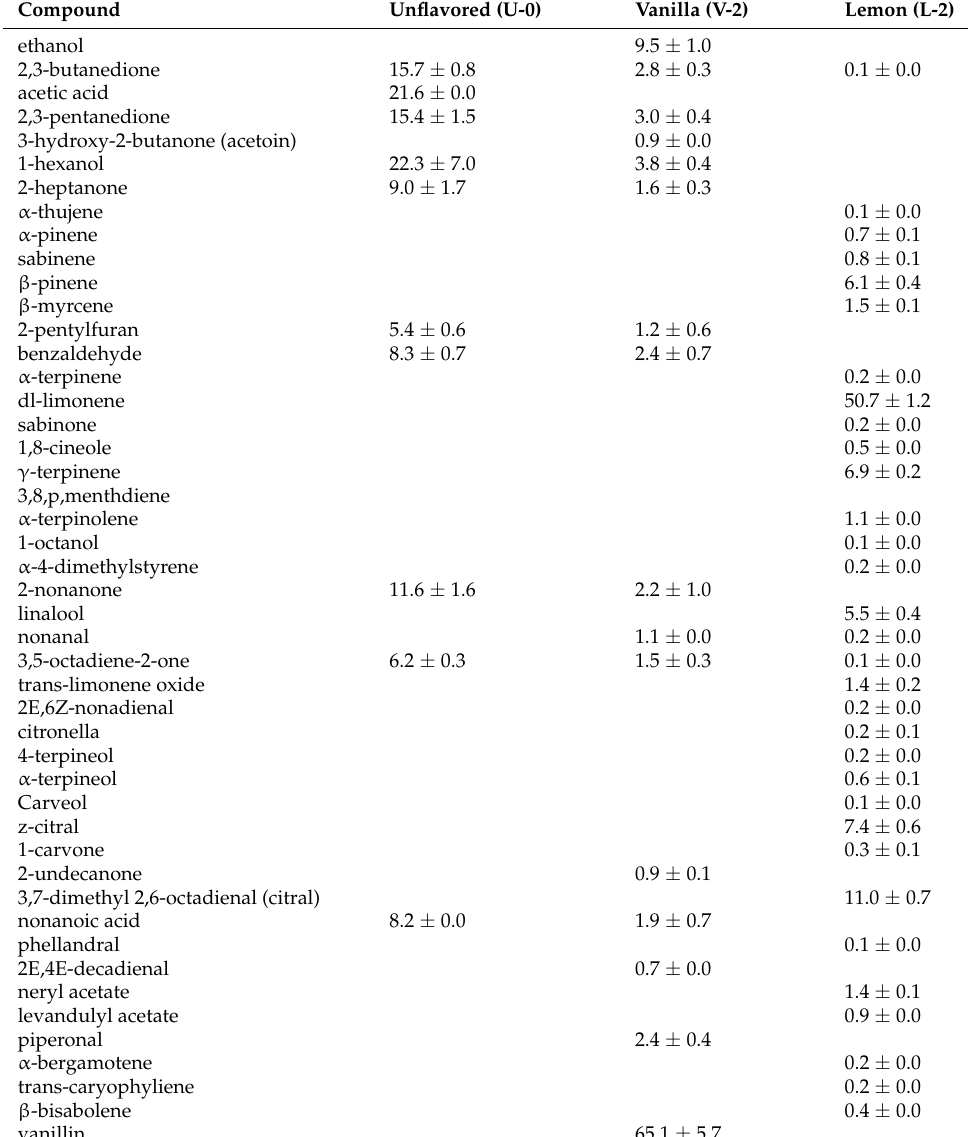
Table 6. Volatile compounds analyzed in the headspace of three different plant-based yogurts (U-0, V-2 and L-2): Mean of Relative Proportions ± Standard Deviation, % ( n = 3). The volatiles are listed in ascending order of retention